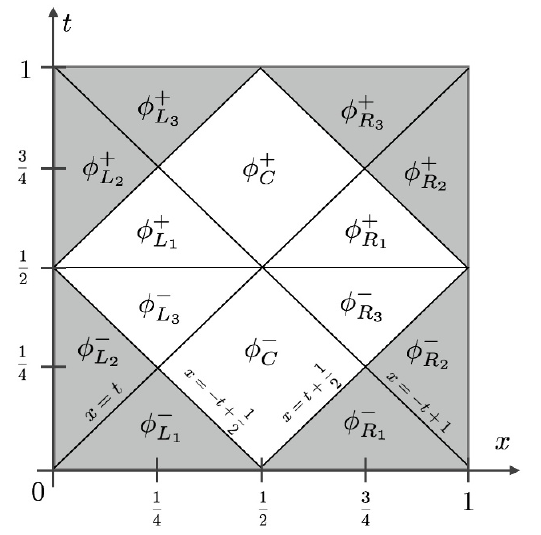
Figure 3. Partial solutions that, together, describe the exact breather of the signum-Gordon